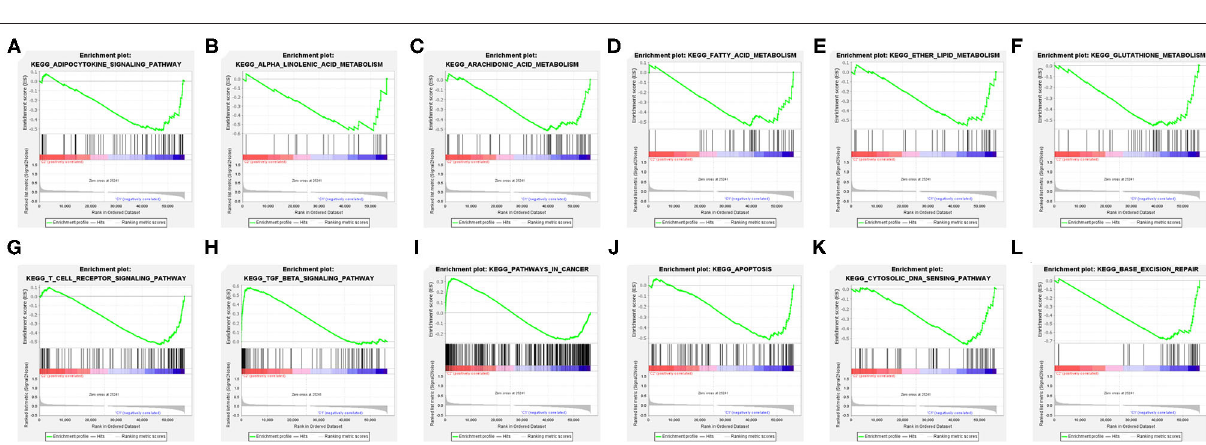
FIGURE 6 | Evaluation of the correlation with immune features between clusters. (A) Immune score between clusters; (B) Stromal score between clusters; (C) The violin plot of comparison of 22 types of immune cells between clusters.